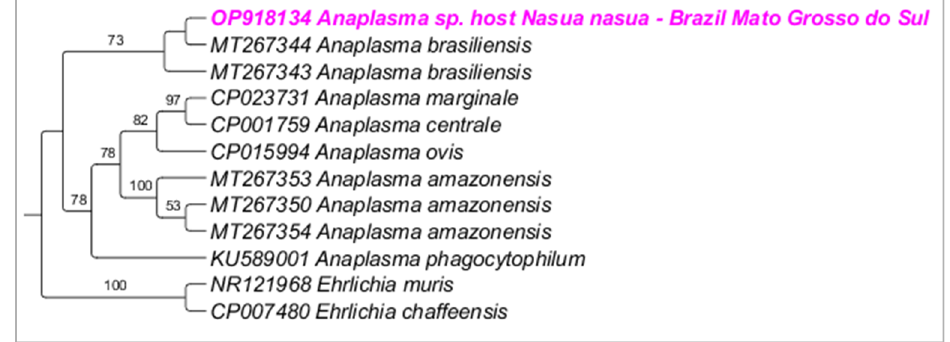
Figure 9. Phylogenetic tree inferred by the Bayesian method and based on the 23S–5S ITS region from Anaplasma spp. sequences obtained from blood from ring-tailed coatis ( Nasua nasua ). Sequences detected in the present study are highlighted in bold pink (VBA) and blue (PEP).